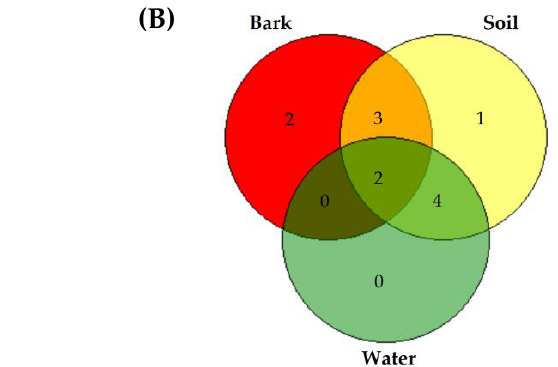
Table 3. Number of isolates of Phytophthora species obtained from stem ( S ), rhizosphere ( R ) and water ( W ) samples in the investigated sites.